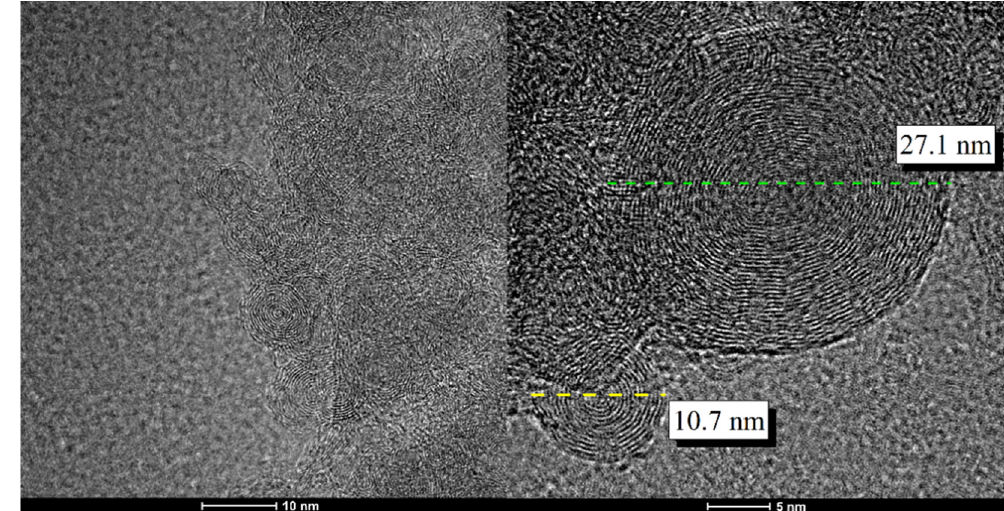
Figure 1. High-resolution transmission electron microscopy (HR-TEM) images of the pristine carbon nano-onions ( p -CNOs) that were obtained by annealing of ultradispersed carbon nanodiamonds under a nitrogen atmosphere at 1600 °C.